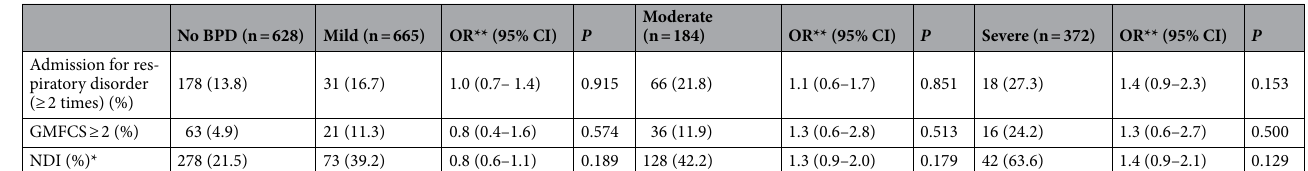
Table 2. Multivariable logistic regression analysis model for the relationship between BPD severity at 36 weeks PMA according to NIH criteria and long-term complications. The odds ratios were calculated using composite score < 70(II) or < 85(III) or K-DST < -2 standard deviations. **OR is adjusted for cesarean section, maternal hypertension, chorioamnionitis, gestational age, birth weight, sex, RDS, air-leakage, pulmonary hemorrhage, pulmonary hypertension, treated PDA, IVH, NEC,